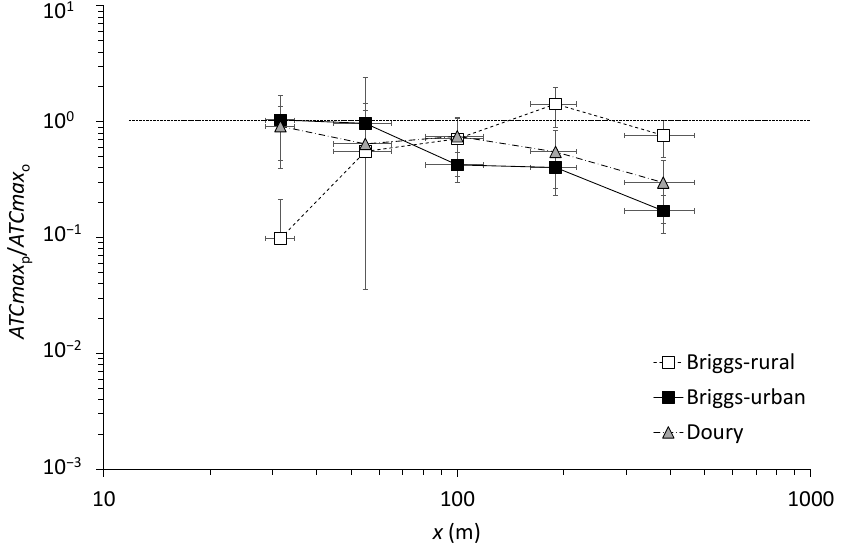
predicted by the measured as a function of 𝐴𝐴𝐴𝐴𝐴𝐴𝐴𝐴𝐴𝐴𝐴𝐴 𝑝𝑝 𝐴𝐴𝐴𝐴𝐴𝐴𝐴𝐴𝐴𝐴𝐴𝐴 𝑜𝑜